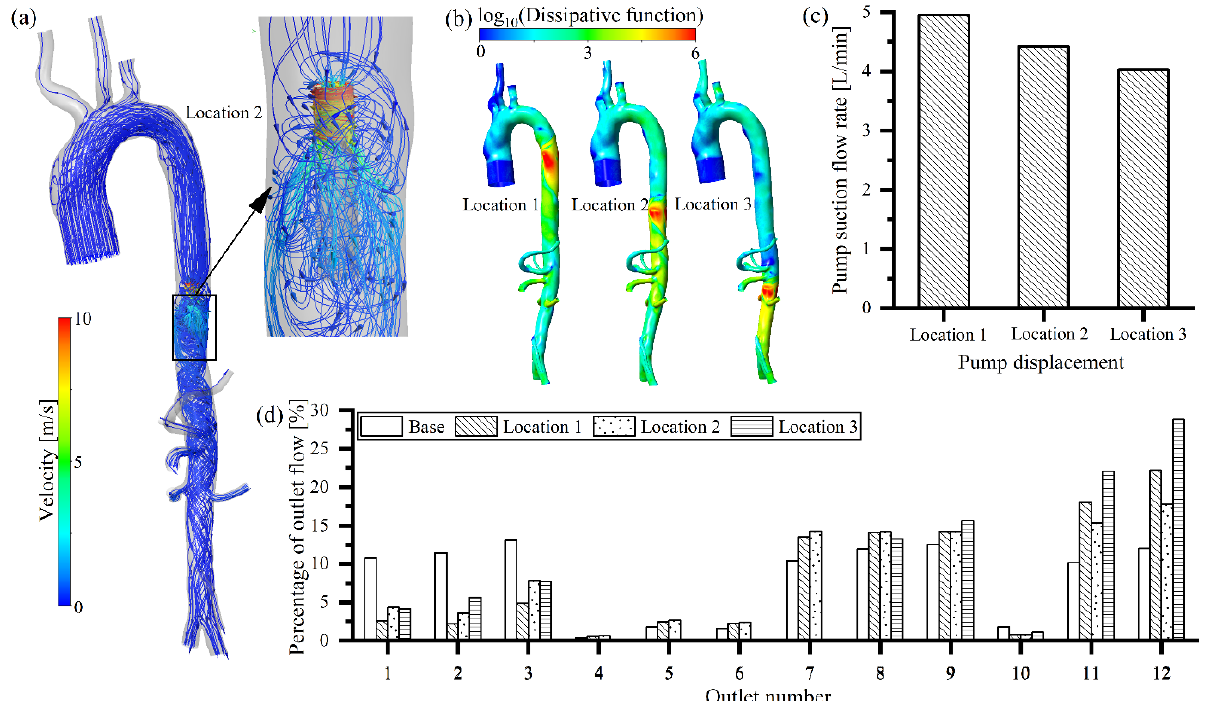
Figure 3. Effects of the different locations of the arterial intravascular pump on flow features: ( a ) effect on arterial flow field; ( b ) effect on pump suction flow; ( c ) effect on energy losses, and ( d ) effect on organ perfusion.